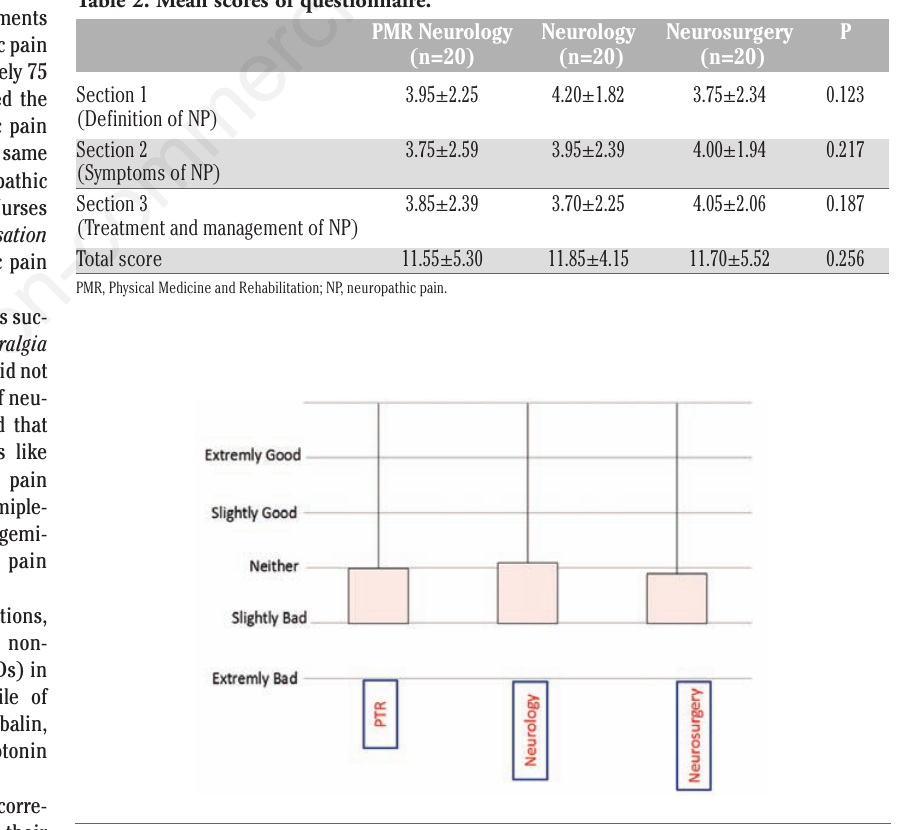
Figure 1. Nurses’ self assessment of their level of